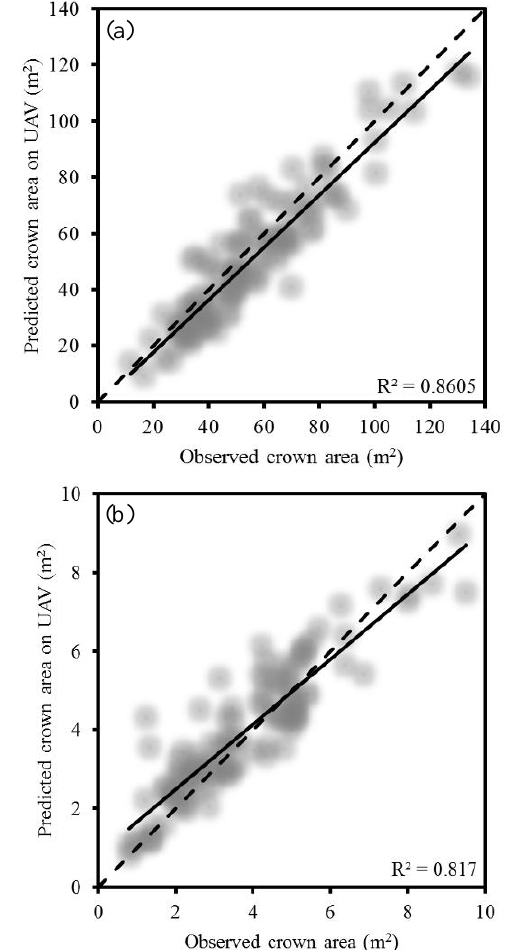
Figure 7. Predicted vs. observed crown area of 100 randomly selected wild pistachios (a) and 100 randomly selected wild almonds (b). Solid lines are the linear regression lines and dotted lines are the 1:1